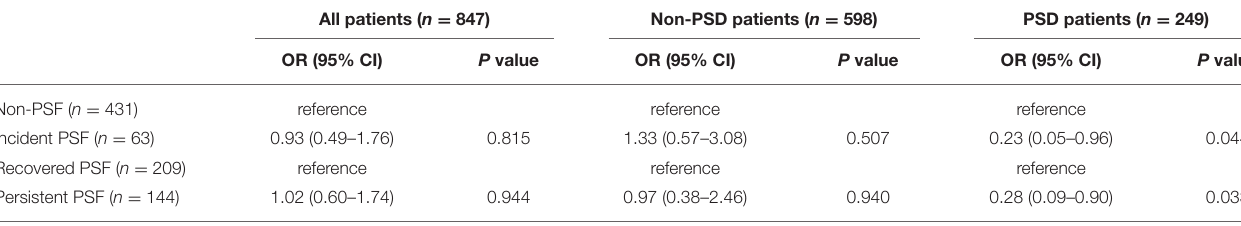
TABLE 2 | Multivariate logistic regression analysis of the association of SSRIs with time course of